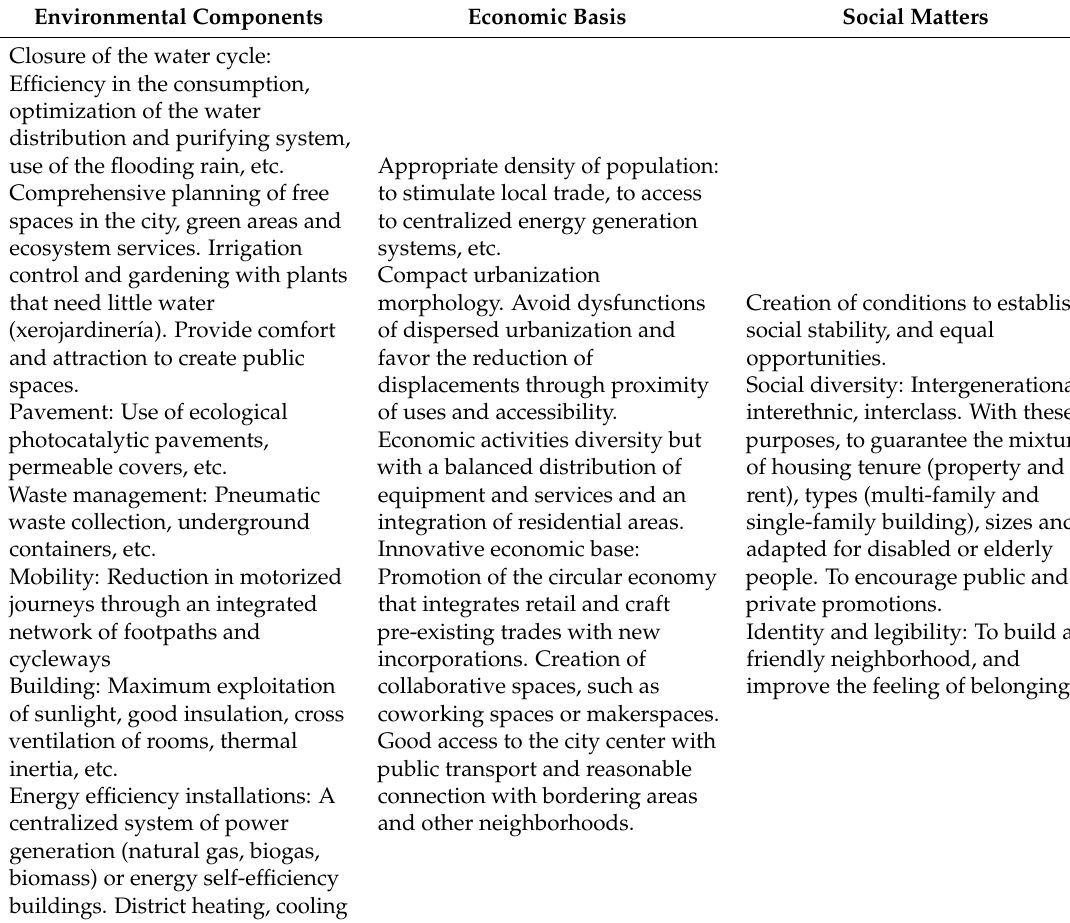
Table A1. Synthesis of the components of the eco-neighborhoods. Source: Realized through the criterions of the specialists referred to the bibliography. The most renowned authors that make a systematization of the basic characteristics of the eco-neighborhoods have been included [2,7,17,18,22, 83]. We also include the criterions of evaluation used by the Madrid City Council in his document of Bioclimatics good practices